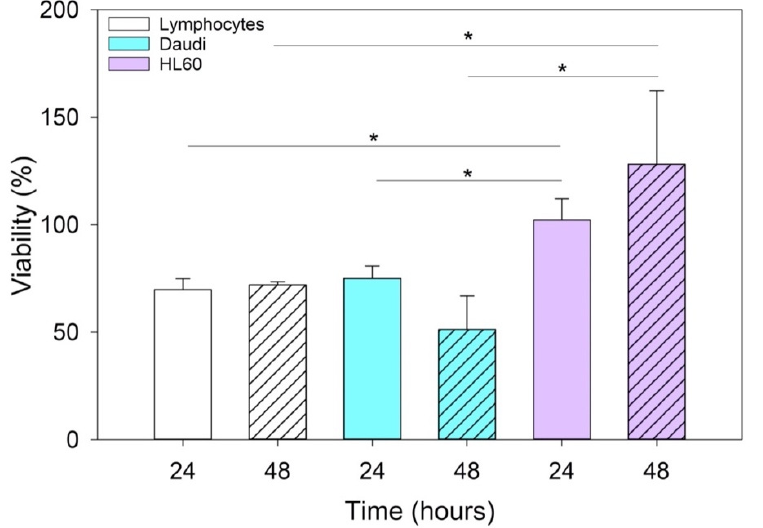
Figure 7. Histograms represent the mean and the SE of the EV CD20 viability data in lymphocytes, Daudi, and HL60 cell lines treated with 5 µg/mL of EVs CD20 solution for 24 and 48 h. The comparisons between cell lines and times of incubation were performed using two-way ANOVA; * p < 0.05. Independent experiments were performed three times.